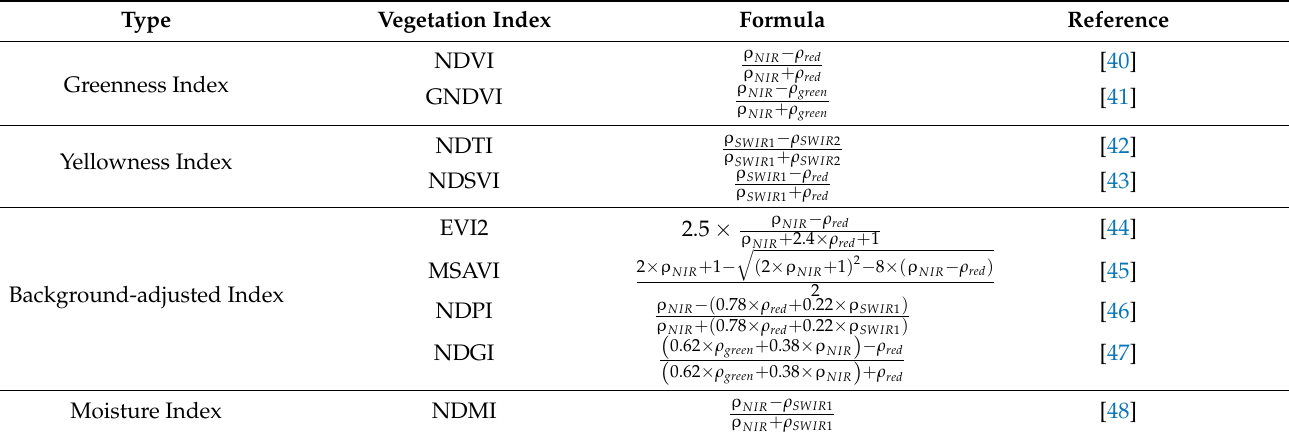
Table 2. Selected vegetation indices for shrub coverage